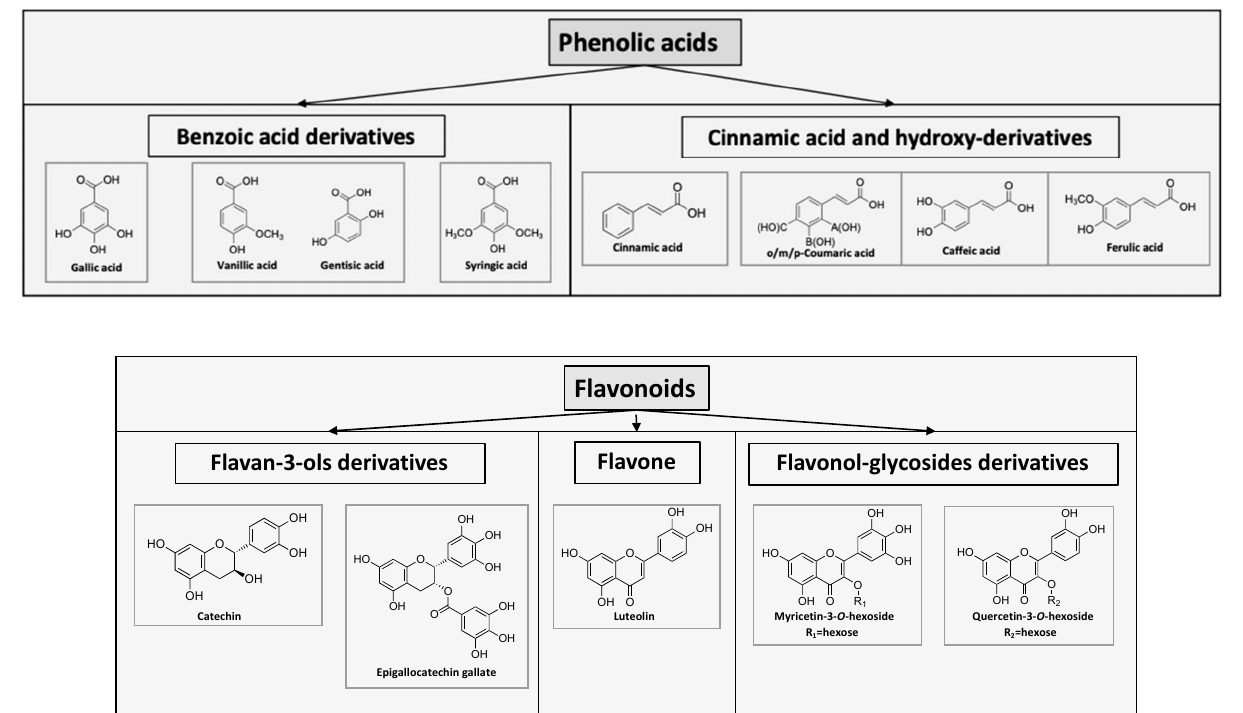
Figure 3. Main phenolic compounds found in carob